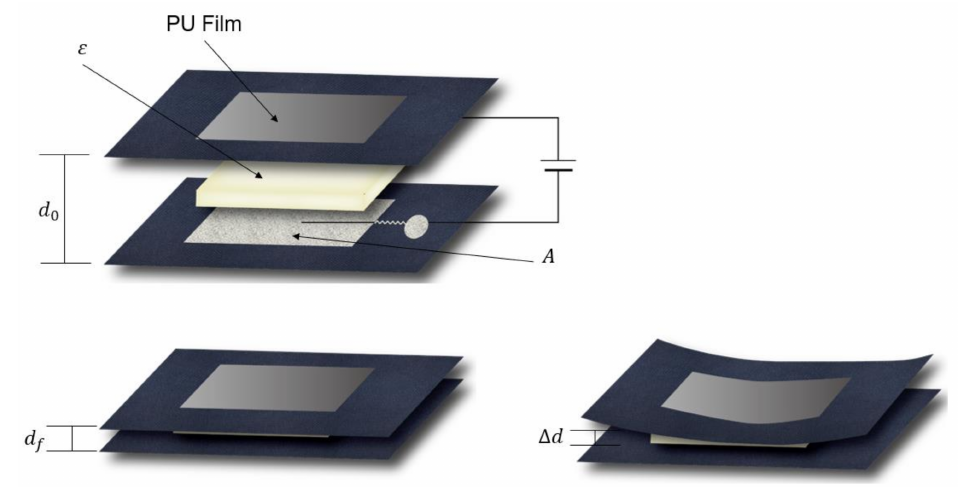
Figure 1. Principle of capacitance measurement of fabricated